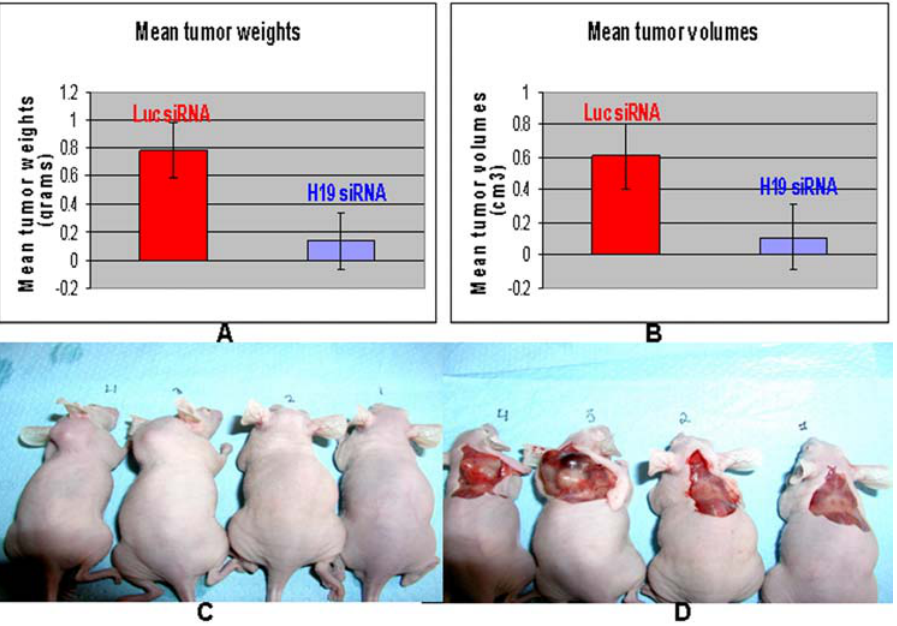
Figure 4. Transient H19 RNA knockdown in Hep3B cells inhibited tumorigenicity in vivo. Hep3B cells were transiently transfected with H19 siRNA3 or Luc siRNA. Forty eight hours post transfection, cells were washed twice with PBS, trypsinized and counted. Equal numbers of cells (1.5 6 10 6 ) were injected subcutaneously into the dorsal part of CD-1 nude mice (n=7 for both, and 4 for mock transfected). Palpable tumors were observed 15 days post inoculation in mice inoculated with Hep3B, transiently transfected with Luc siRNA. Tumor volumes were followed up and measured using a caliper until day 30 post inoculation, after which mice were sacrificed. Significant (p , 0.03) reductions of about 82% of both mean tumor weights (A) ( 6 standard error) and mean tumor volumes (p , 0.03) (B) ( 6 standard error) were observed. Values represent end-points just before and after sacrificing animals. Shown are also representative features of tumors in 2 mice of each group (mice 1 and 2 are the H19 siRNA3 treated Hep3B cells, and mice 3 and 4 are the Luc siRNA ) before tumor surgical exposure (C) , and after exposure of their internal tumors (D) .